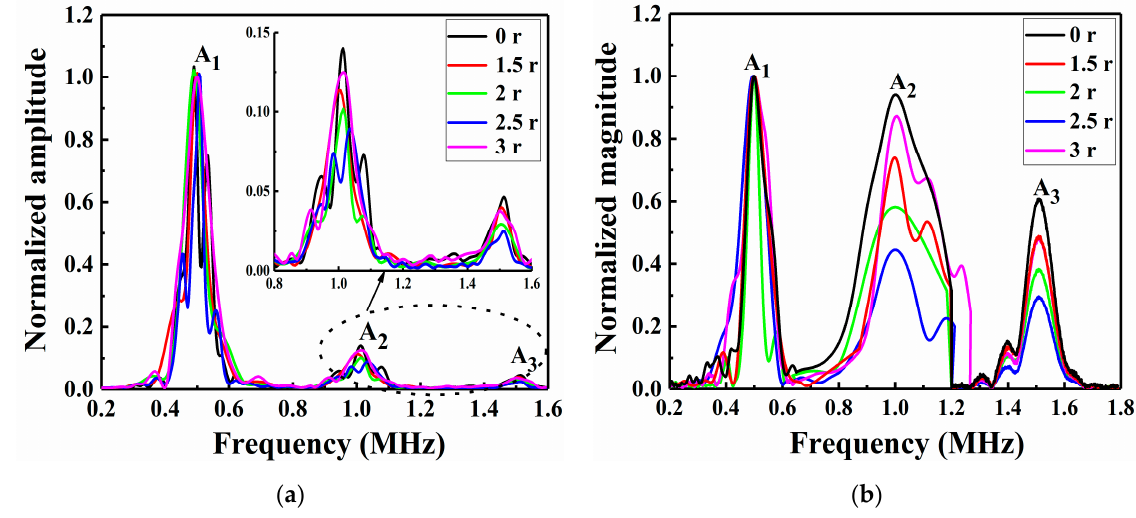
Figure 20. Frequency-domain responses of specimens repaired with patches of various sizes: ( a ) numerical and ( b ) experimental results.